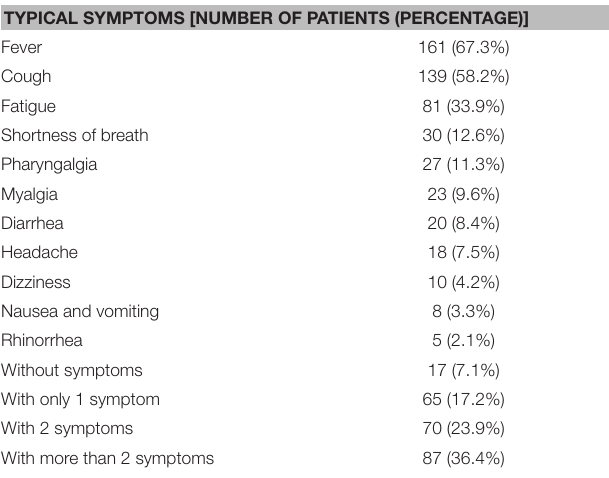
TABLE 3 | Clinical symptoms of patients at admission.